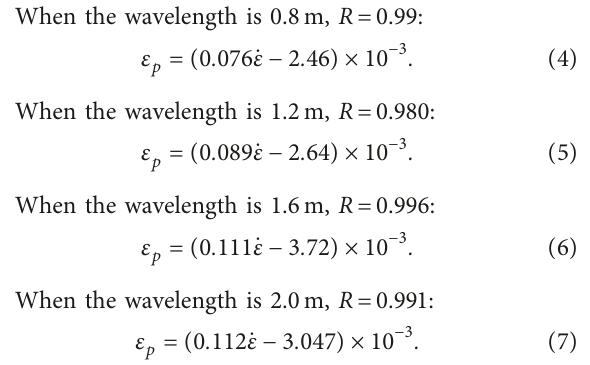
Figure 4: Relationship between wavelength and peak